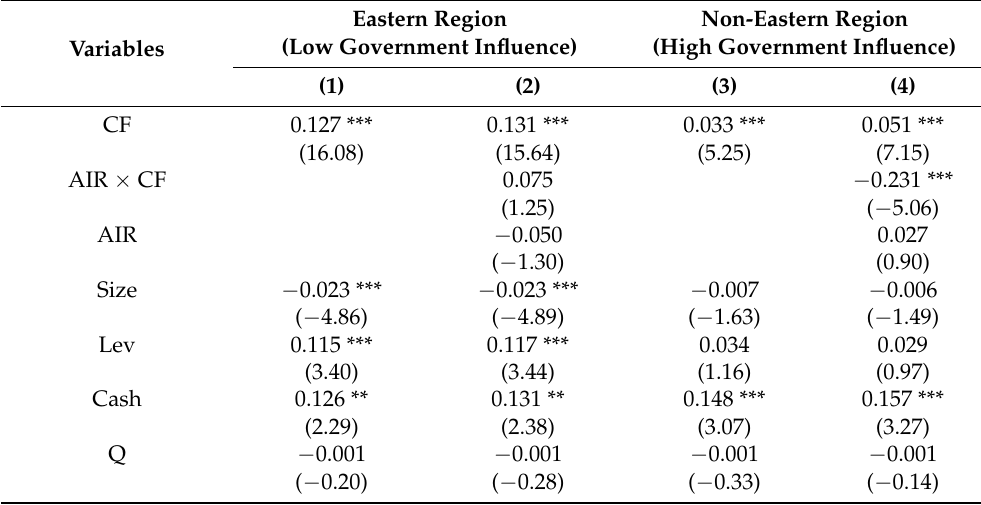
Table 7. Grouping based on government